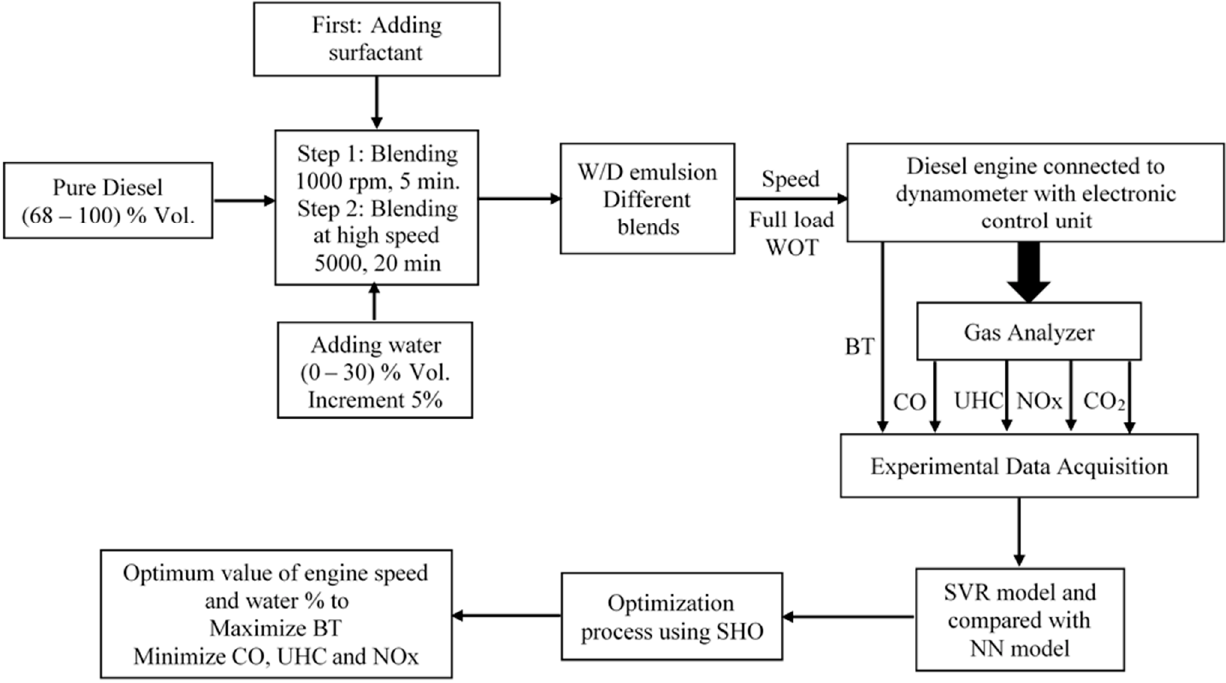
Figure 1. A conceptualization of the experimental approach coupled with an optimization tech-